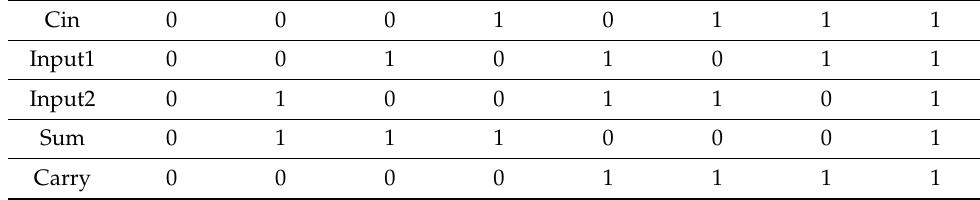
Table 4. Logic truth table of the full